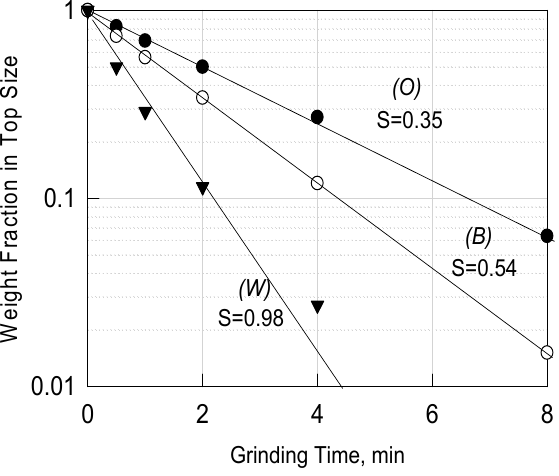
Figure 4. First-order-plot for the 16 × 20 mesh materials ( O ), ( B ) and ( W ) .